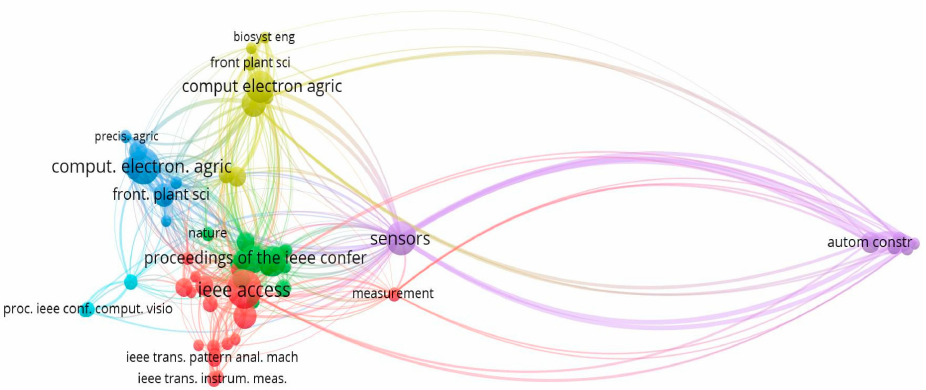
Figure 27. Journal Wise Co-citation Sources Network (Source: https://www.vosviewer.com (accessed on 14 September